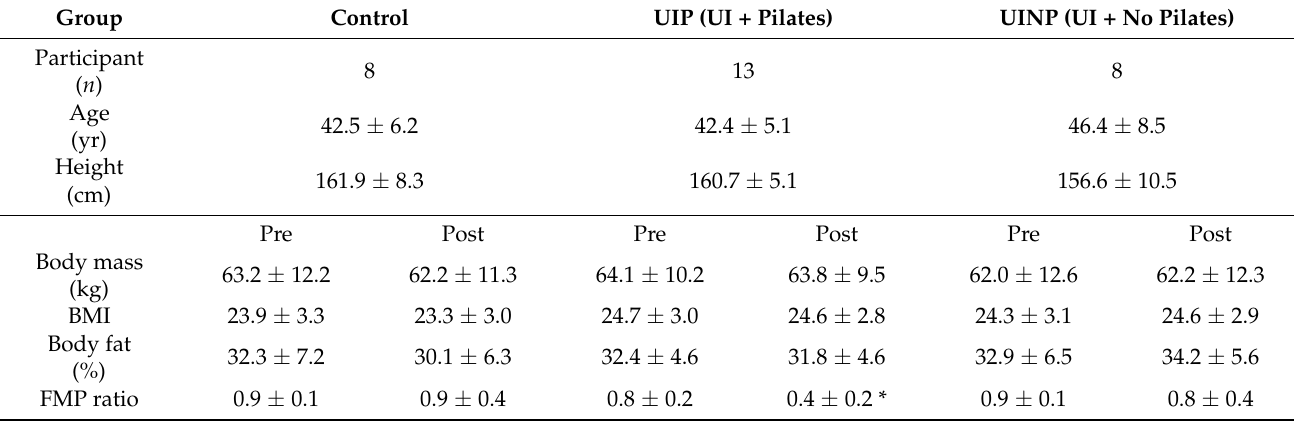
Table 1. Demographic characteristics and pelvic floor muscle (PFM) function of